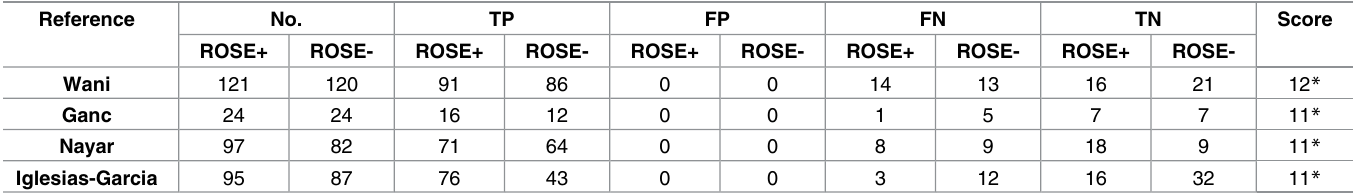
ROSE, rapid on-site evaluation; TP, true positive; FP, false positive; FN, false negative; TN, true negative. * Quality of study was evaluated using the Quality Assessment of Diagnostic Accuracy Studies (QUADAS) tool.